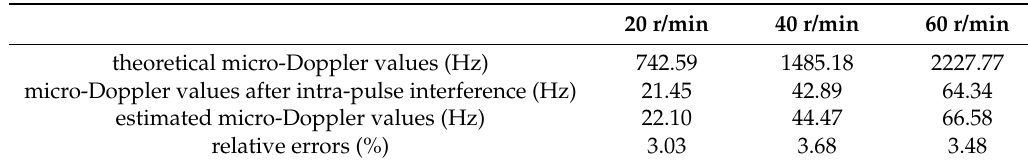
Figure 8. Time–frequency distributions of corner reflectors rotating at 60 r/min ( a ) before and ( b ) after intra ‐ pulse interference processing. Table 1. Comparison between theoretical values and estimated values of micro-Doppler value of the corner reflector rotating at 24